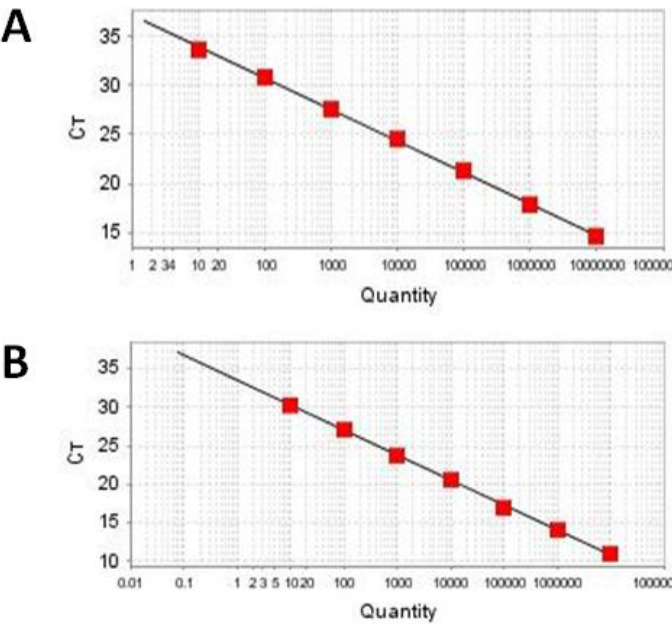
Figure 1. Amplification plots and standard curves for HAV-HEV multiplex TaqMan real-time PCR. The limit of detection and the linearity of the standard curves were determined by using a 10-fold dilution series of HAV and HEV gene fragments ranging from one to 10,000,000 copies. Ct values obtained from the 10-fold dilution series were plotted against the logarithm of the absolute amount of RNA copies. The linear regression equation of the standard curve for hepatitis A virus detection is Y = − 3.317 X + 38.228 ( R 2 = 0.999) ( A ); The linear regression equation of the standard curve for hepatitis E virus detection is